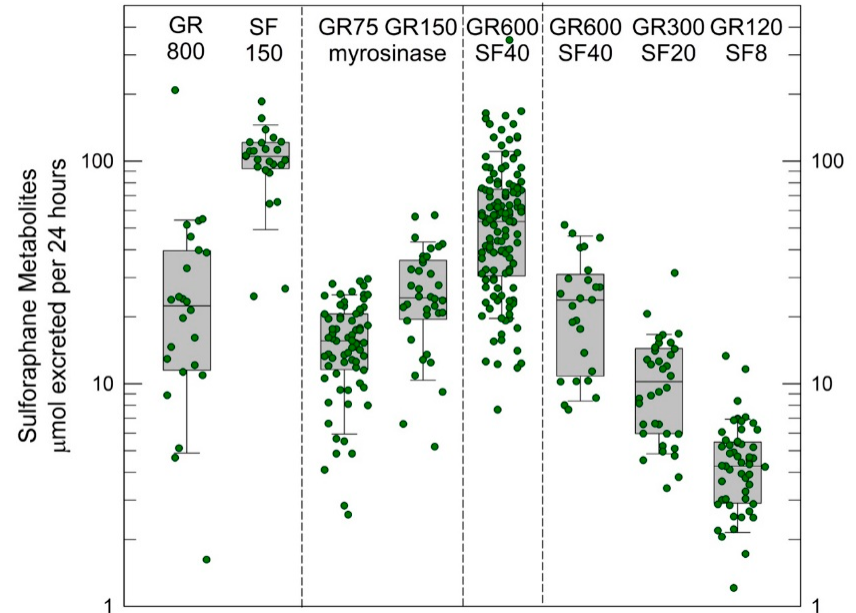
Figure 4. Urinary excretion of sulforaphane metabolites (“internal dose”) per 24 h following an initial dose with different broccoli sprout preparations from intervention studies conducted in Qidong China [63,77,78]. All analyses were conducted by isotope dilution mass spectrometry. Values are the sum of sulforaphane, sulforaphane-cysteine and sulforaphane- N -acetylcysteine for each participant. Box plots are median and 5% and 95% confidence intervals. GR 800 was a beverage prepared from a hot-water extract of 3-day old broccoli sprouts that was lyophilized, and then reconstituted in mango juice and water to deliver 800 μ mole glucoraphanin (GR); SF 150 was the hot-water extract cooled to room temperature, treated with daikon to deliver myrosinase, then lyophilized and later reconstituted in mango juice and water to deliver 150 μ mol of sulforaphane (SF). GR600 + SF 40 were beverages reconstituted in pineapple juice, lime juice and water from their lyophilized powders to deliver a dose of 600 μ mol of GR and 40 μ mol SF. In addition to beverages, a study was conducted with a commercial dietary supplement formulated as tablets constituted from lyophilized broccoli sprouts and finely